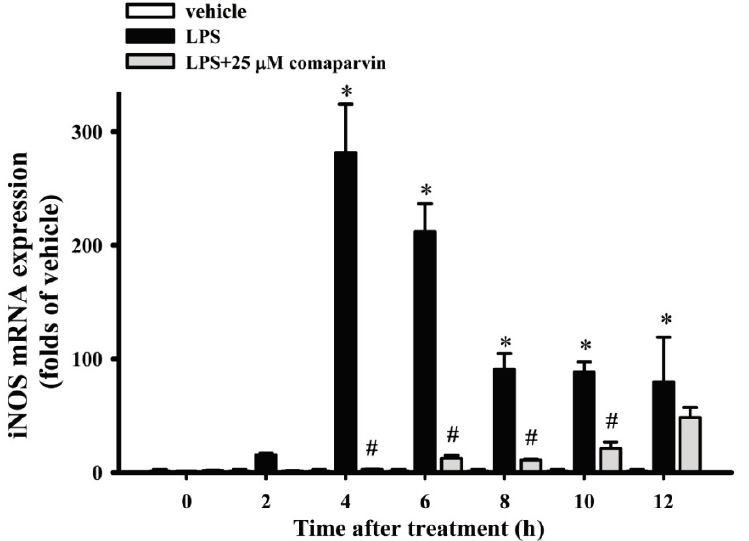
Figure 4. Effects of comaparvin on the expression of iNOS mRNA in LPS-stimulated macrophage cells. Cells were incubated with 25 μ M comaparvin for 10 min and, then,